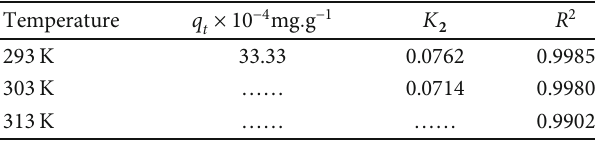
Table 3: Pseudo-second-order kinetic constants.